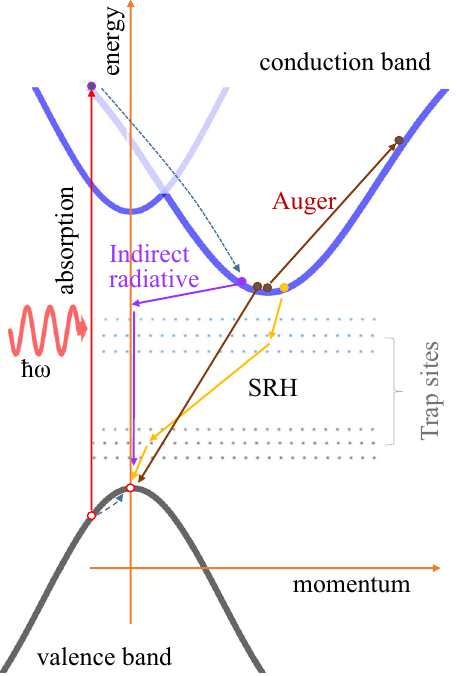
Fig. 1 Schematic band diagram of anatase TiO 2 which has an indirect band gap. The simpli fi ed optical excitation and possible decay processes are